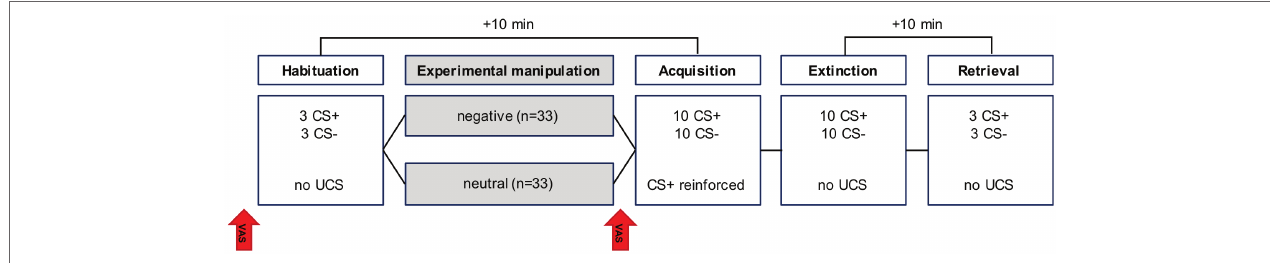
FIGURE 1 | Outline of the fear conditioning paradigm and the experimental manipulation. The arrows denote the manipulation check. Breaks of 10 min were imposed between habituation and acquisition (to deliver the feedback) as well as between extinction and